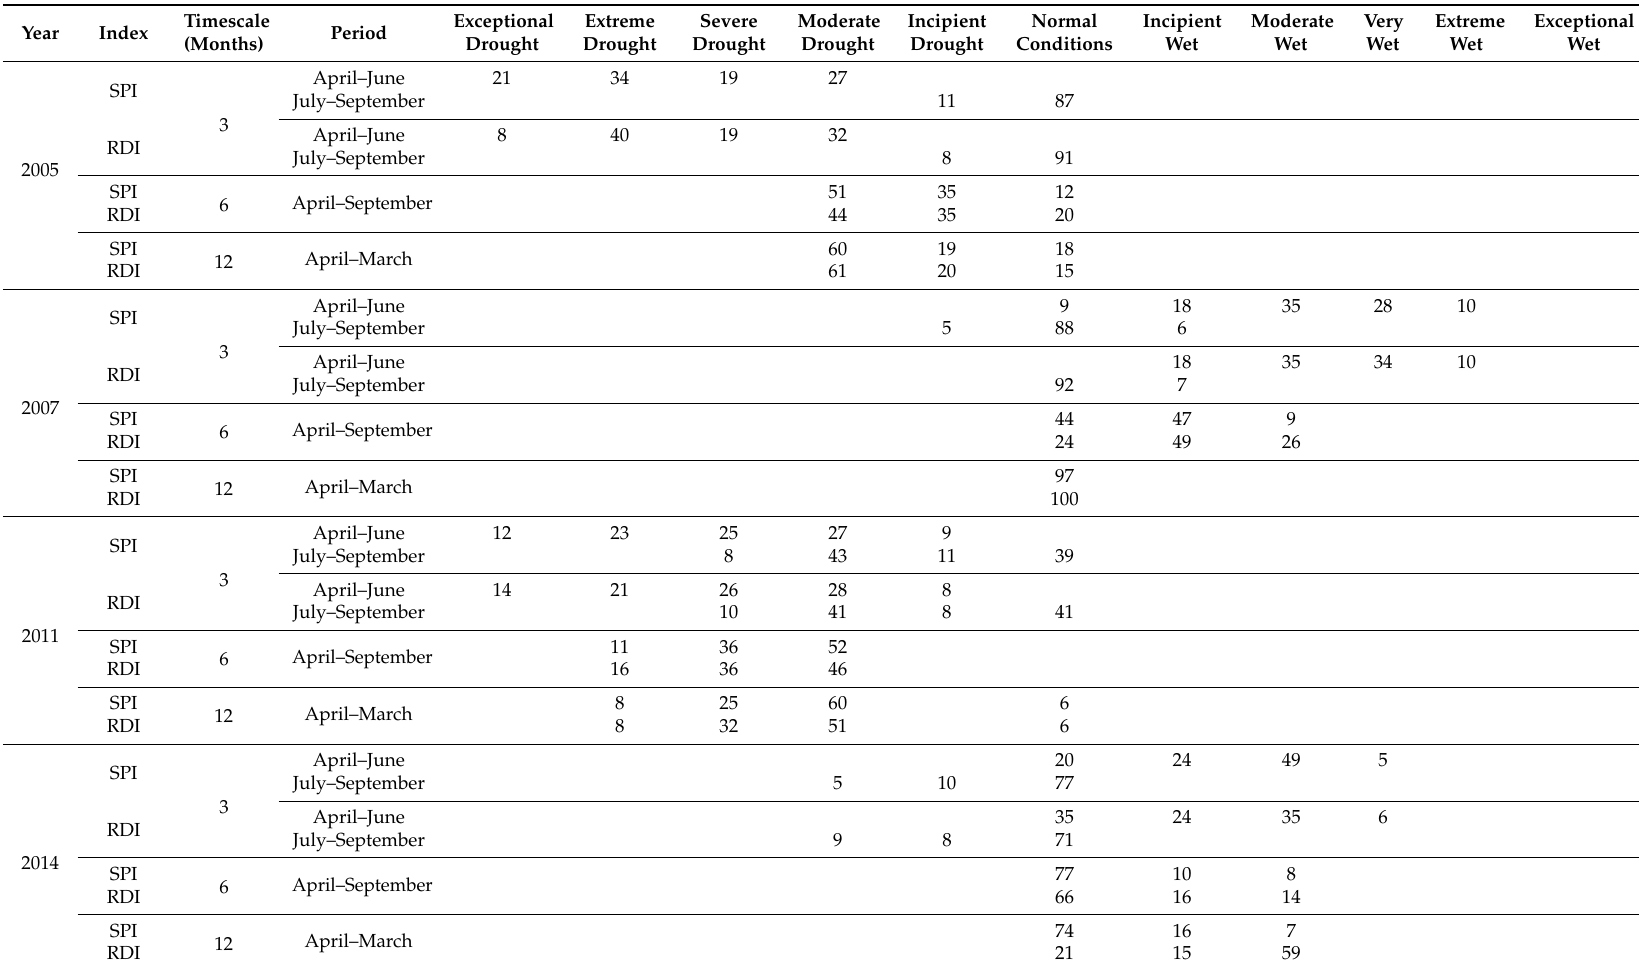
Table 2. Percent of Zacatecas territory exposed to different drought conditions in 2005, 2007, 2011, and